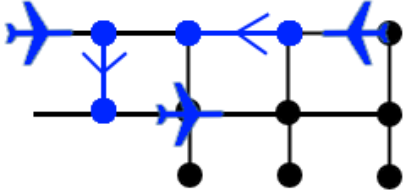
Figure 2. Conflict-based highways example. Blue edges indicate the conflict-based highway and its directionality. The blue nodes are the areas with a high number of anticipated